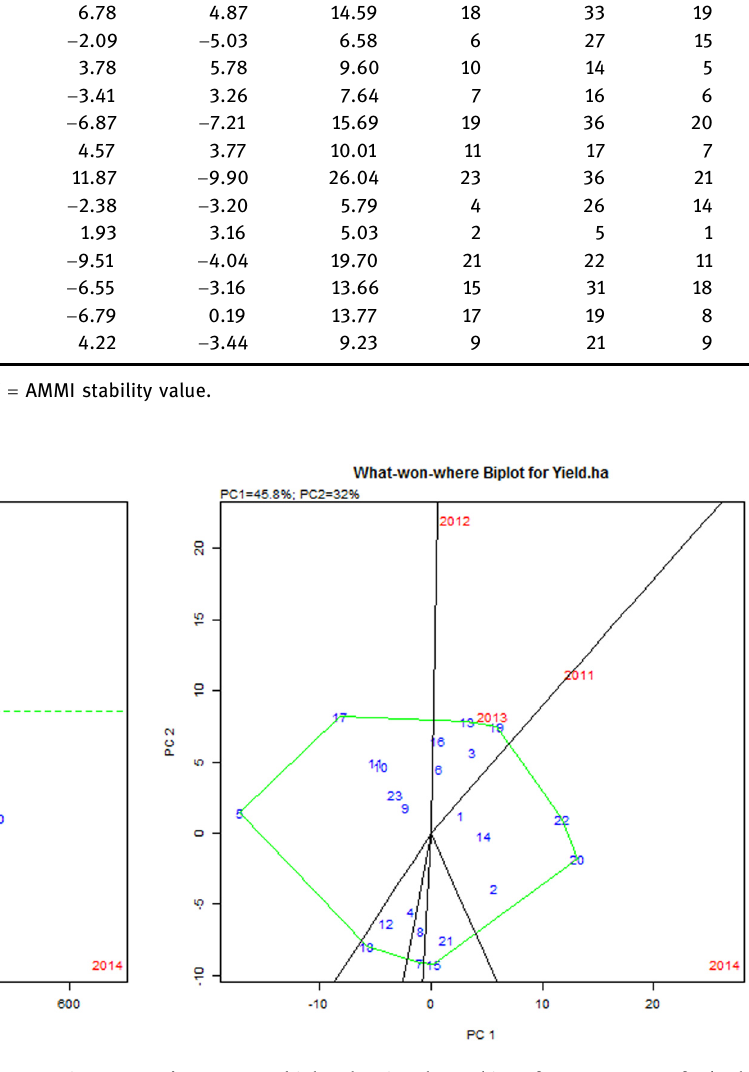
Figure 1: Polygon view of the GGE biplot showing the superior AYB genotypes across the four - year environment.